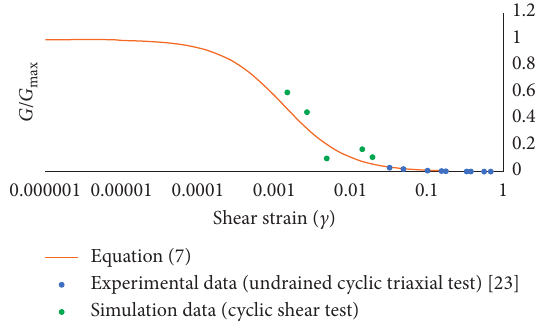
Figure 4: Calibration of kinematic hardening model for clay against the G − c curve of undrained cyclic triaxial test.